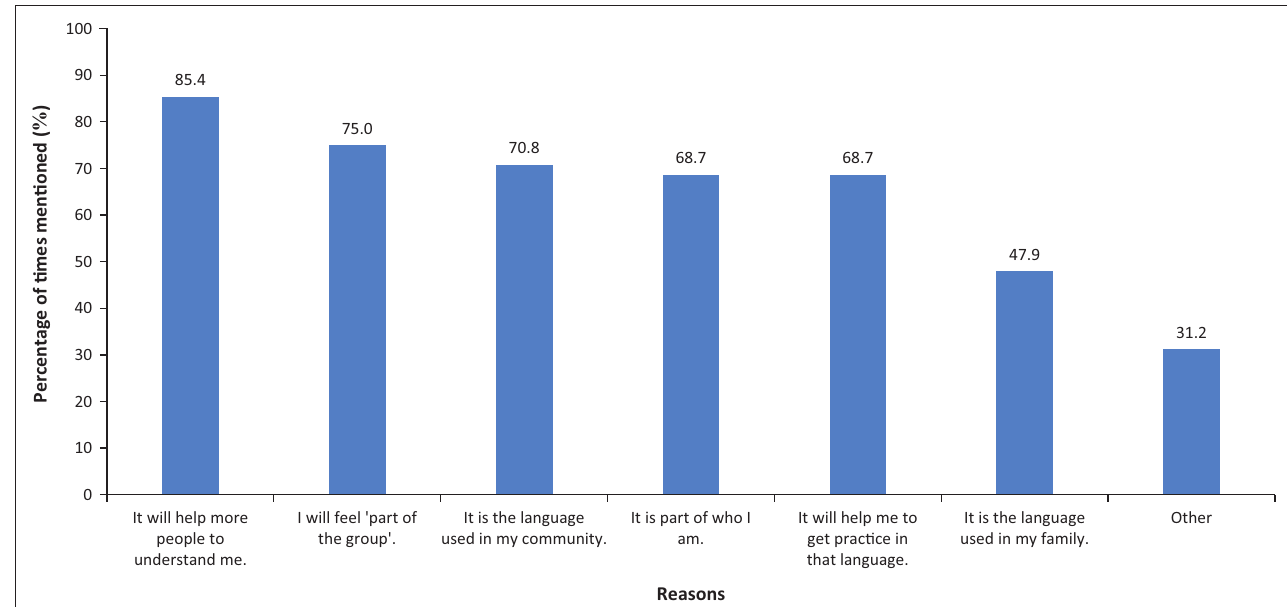
FIGURE 2: Frequency with which reasons for wanting increased or additional access to languages were chosen by the